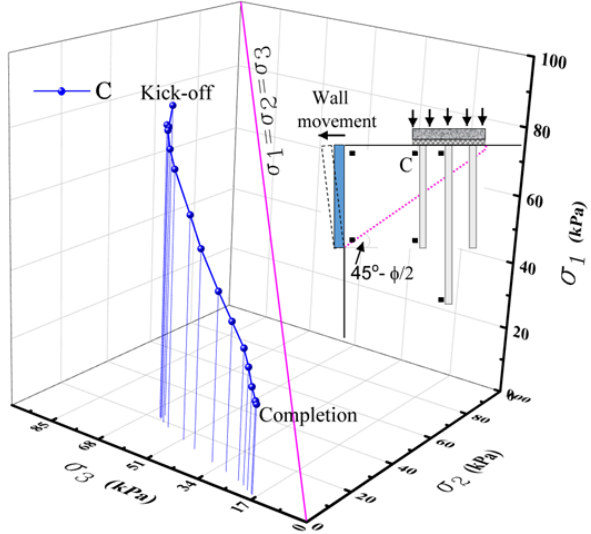
Figure 6: Principal stress changes during wall rotation about the base for nine long–short pile composite foundation located at 3 m away from the